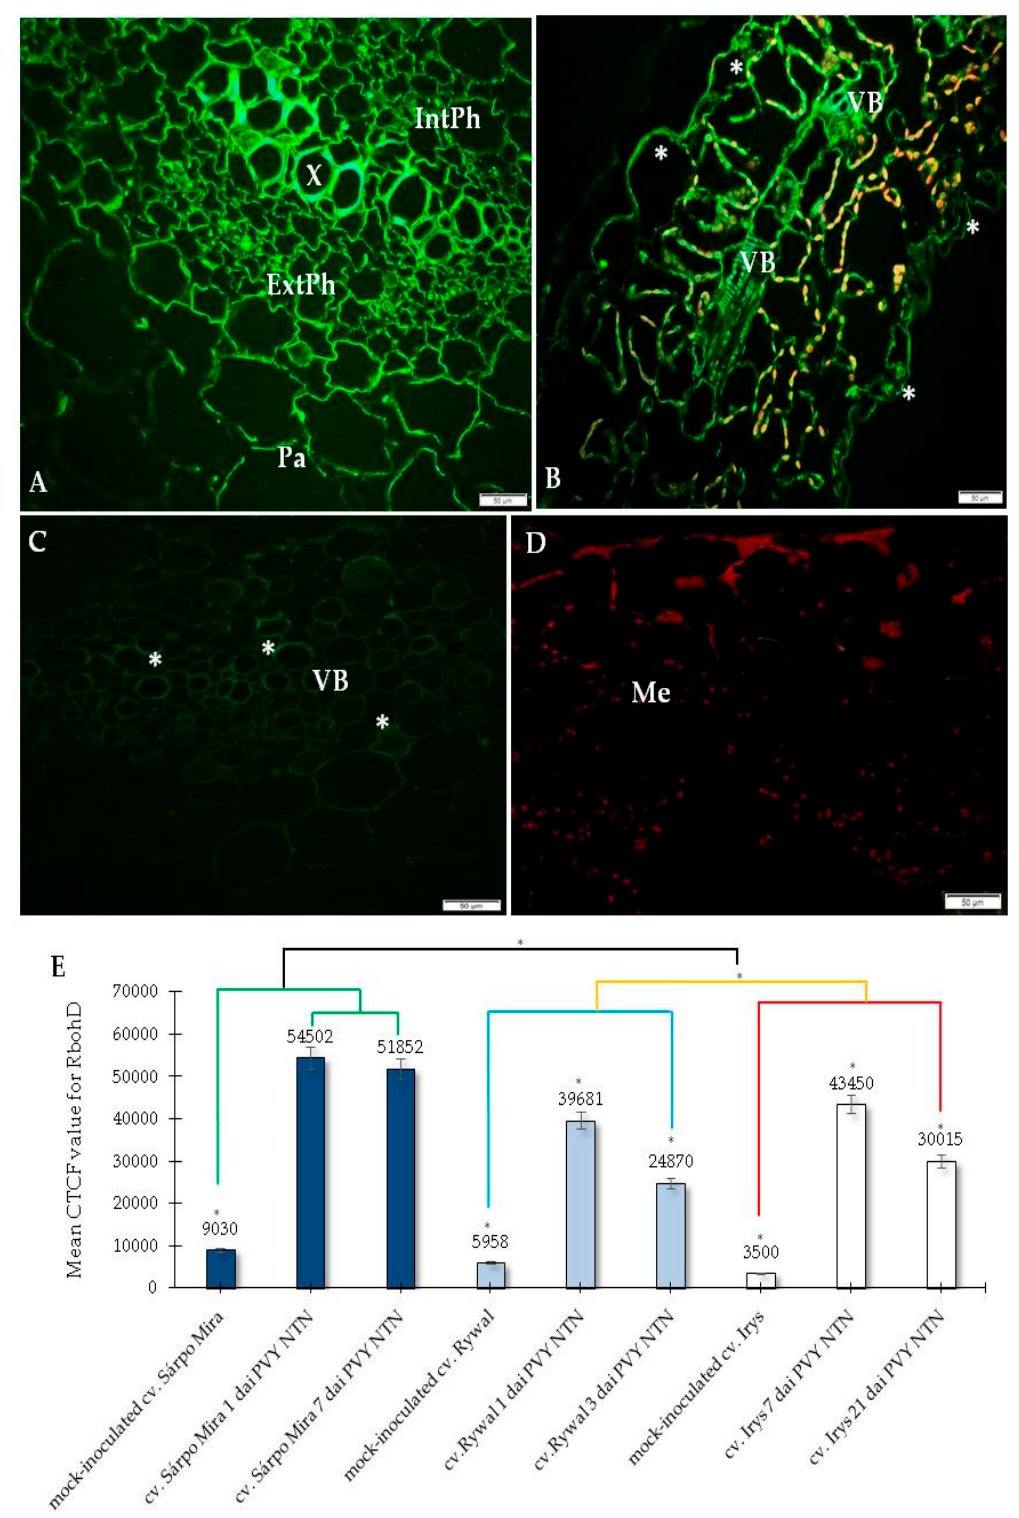
Figure 1. Fluorescence detection of RbohD protein in an incompatible interaction of potato Sárpo Mira plants with potato virus Y (PVY) NTN ( A – D ) and the assessment of the quantitative fluorescence signal in all interactions ( E ). ( A ) The green fluorescence signal of RbohD (*) in xylem, external and internal